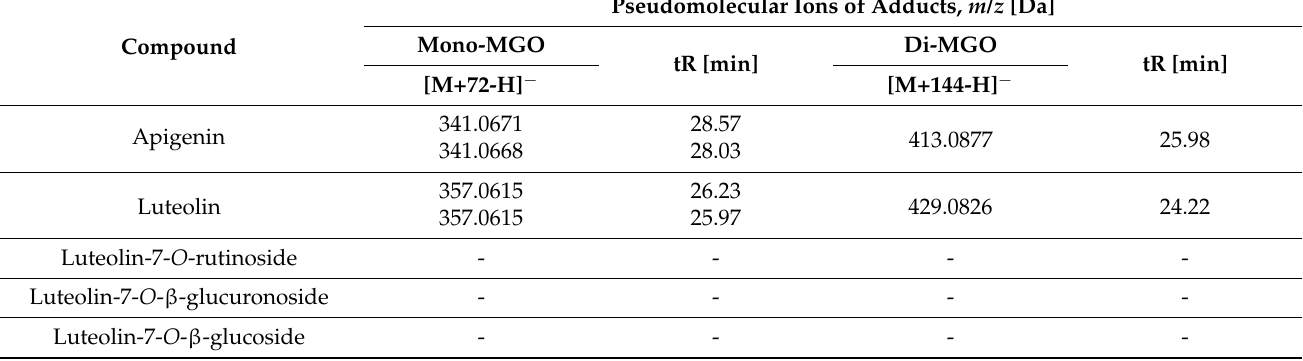
Table 3. Adducts of methylglyoxal with selected standards and polyphenols identified in peppermint leaf dry